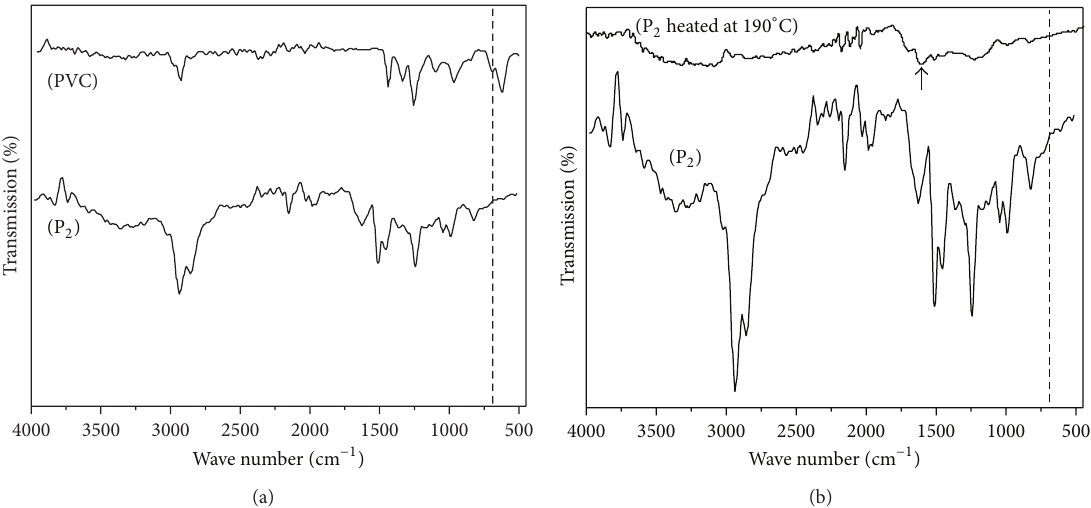
Figure 4: IR spectra of (a) PVC and (P 2 ) and (b) (P 2 ) and (P 2 ) heated at 190 ∘ C.